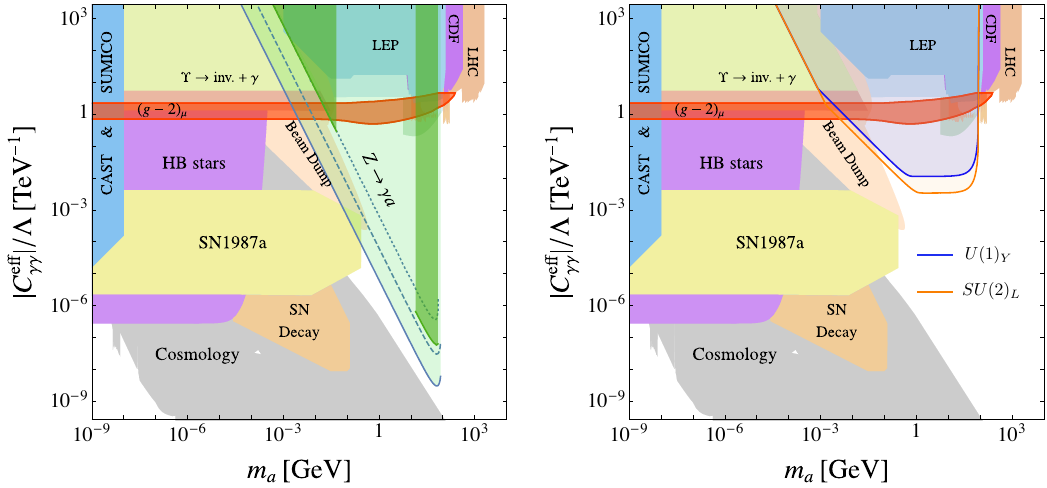
Figure 23 . Constraints on the ALP mass and coupling to photons derived from various experiments (colored areas without boundaries, adapted from [24]) along with the parameter regions that can be probed in LHC Run-2 with 300 fb (cid:0) 1 of integrated luminosity using the decay Z require at least 100 signal events. Left: regions that can be probed are shaded in light green. The contours correspond to C e(cid:11) = (cid:3) = 1 TeV (cid:0) 1 (solid), 0 : 1 TeV (cid:0) 1 (dashed) and 0 : 01 TeV (cid:0) 1 (dotted). (cid:13)Z j j The dark green regions are excluded by existing measurements assuming that The red band shows the preferred parameter space where the ( g 95% CL. Right: regions that can be probed in scenarios where the ALP couples only to hypercharge gauge (cid:12)elds (solid blue) or only to SU(2) L gauge (cid:12)elds (solid orange). This plot refers to 1 TeV (cid:0) 1